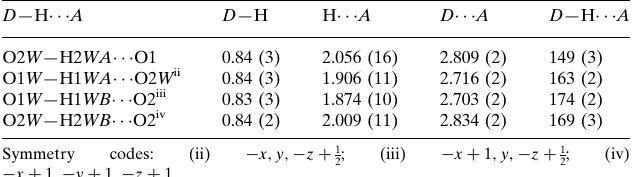
Hydrogen-bond geometry (A˚ , (cid:2)